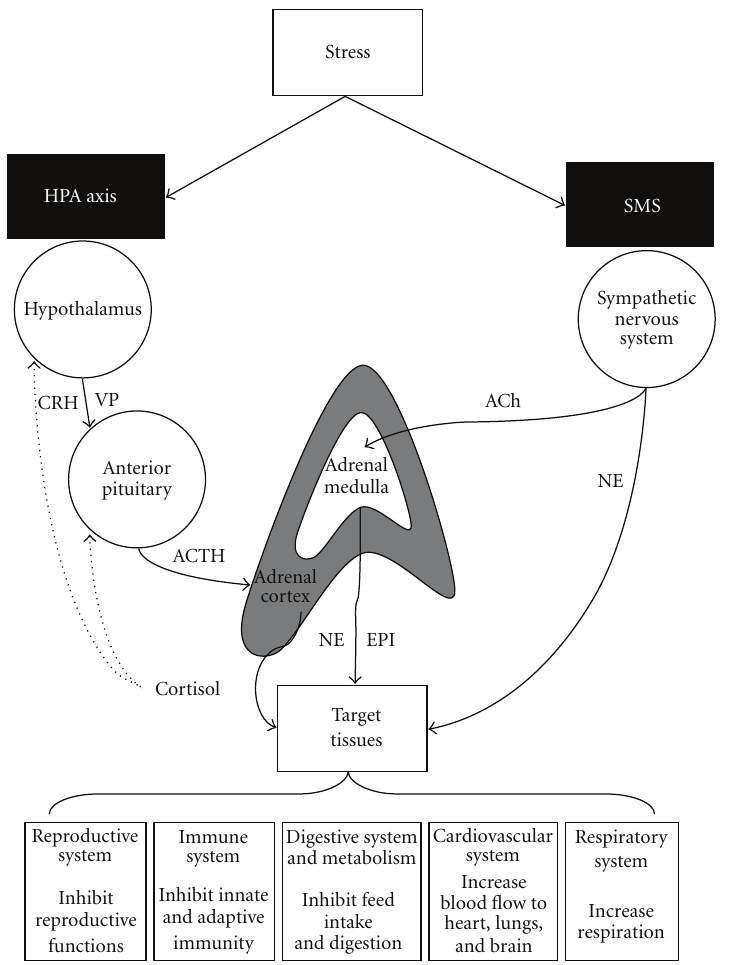
Figure 1: Schematic representation of the hypothalamic-pituitary-adrenal (HPA) axis and sympathomedullary system (SMS) response to stress. CRH: corticotrophin releasing hormone; VP: vasopressin; ACTH: adrenocorticotropic hormone; ACh: acetylcholine; NE: norepinephrine; EPI: